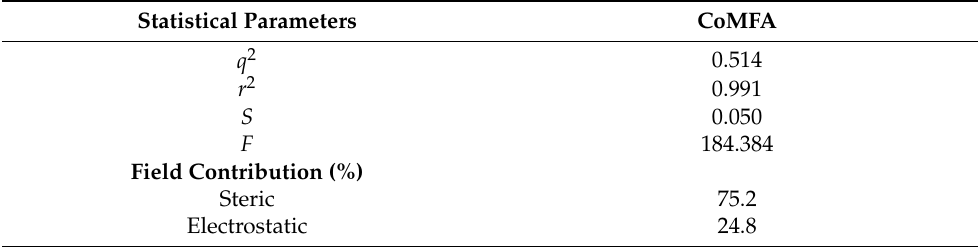
Table 2. Summary of CoMFA analysis.